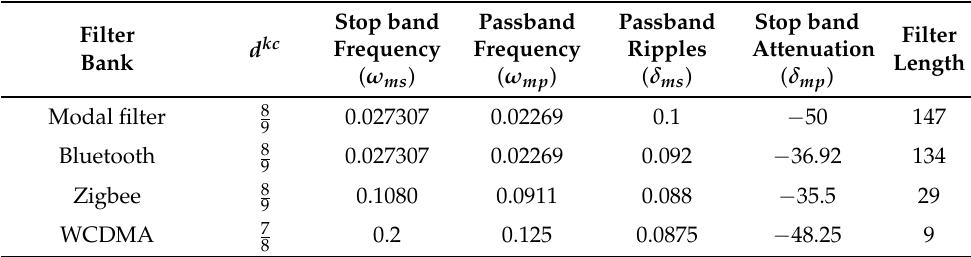
Table 5. The frequency characteristics of the complementary masking filter implemented using the HFarrow filter